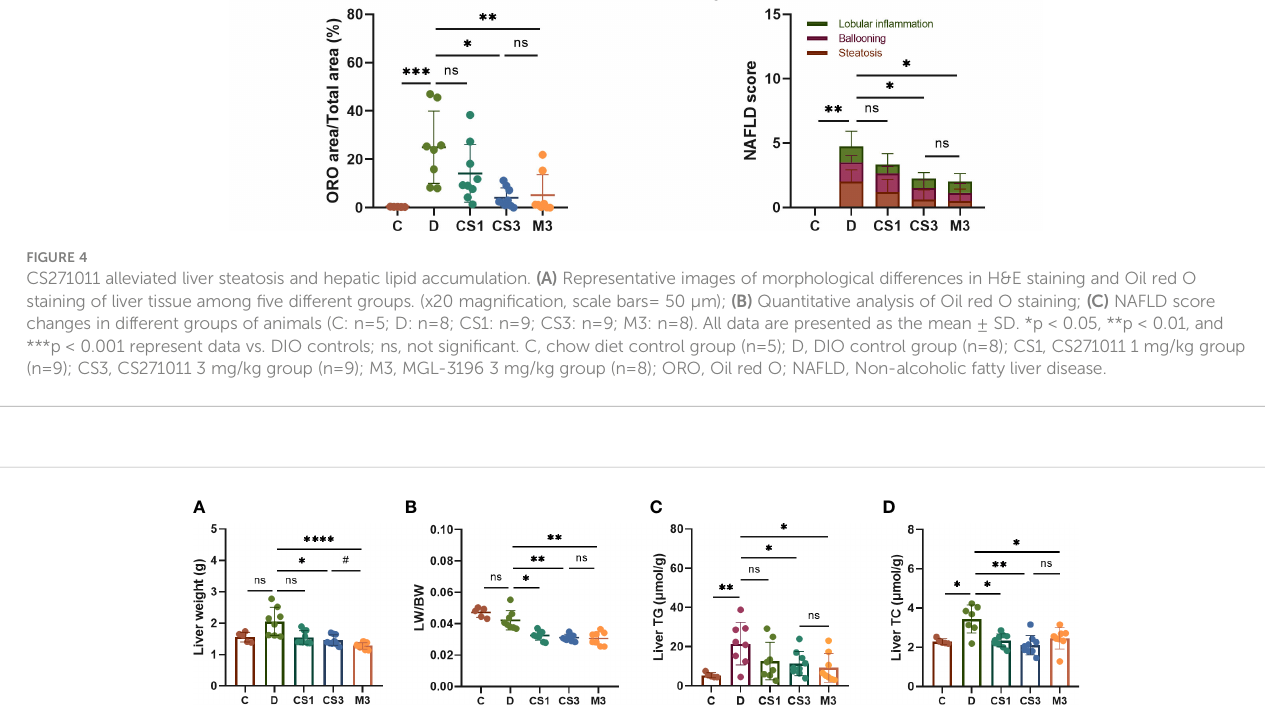
steroid function (Figure 8D). The hub genes of the DIO and CS271011 1 mg/kg groups analyzed by the PPI network are shown in Supplementary Figures S4E, F.